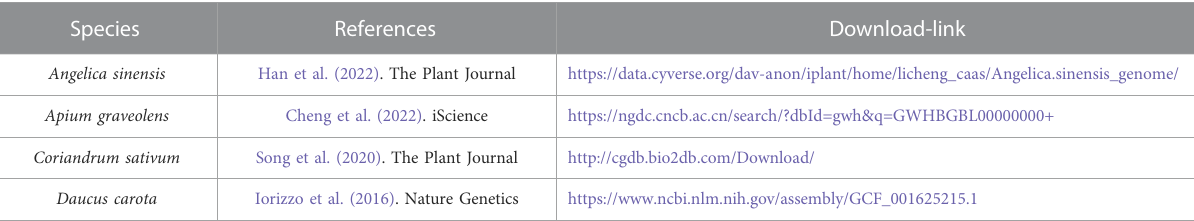
TABLE 1 Metadata of the genomes from four Apiaceae species.